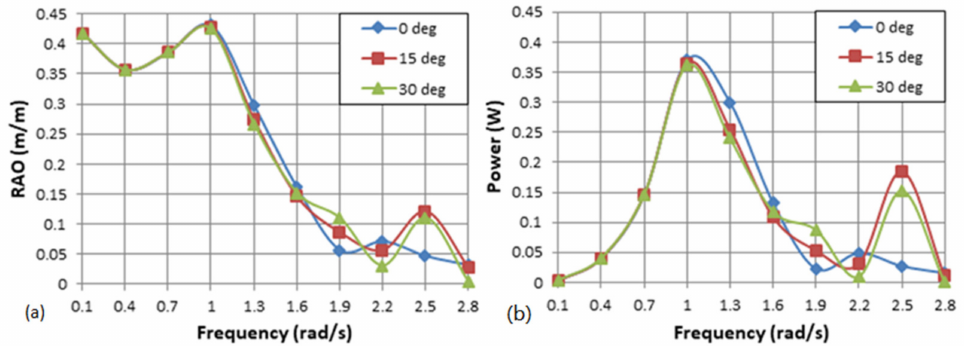
Figure 10. The heave motion ( a ) RAO and ( b ) power with 0, 15 and 30 degrees of incident wave direction on the central body.